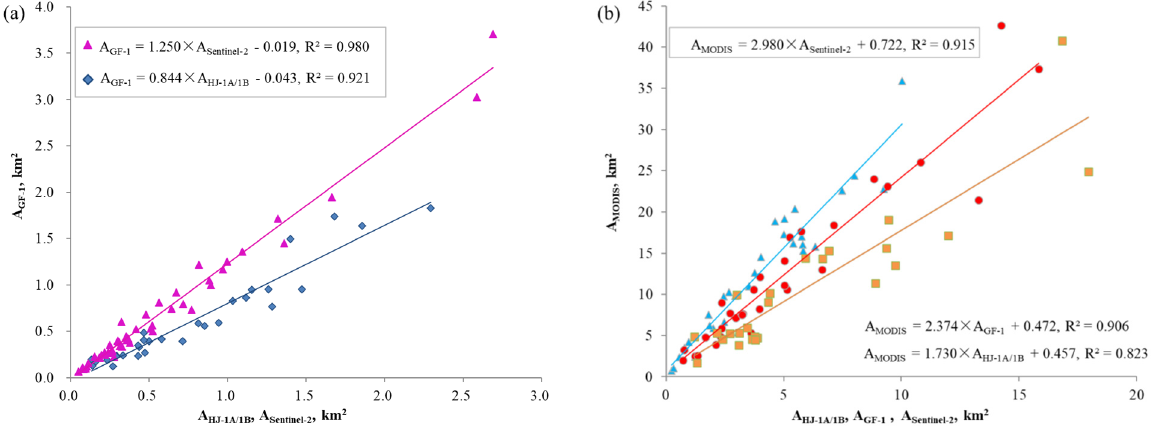
Figure 2. ( a ) Comparison in the macroalgae coverage areas derived from the optical images of HJ-1A/1B, GF-1 and Sentinel-2, i.e., A HJ-1A/1B , A GF-1 , A Sentinel-2 , respectively. ( b ) Comparison in the macroalgae coverage areas derived from the optical images of MODIS, HJ-1A/1B, GF-1 and Sentinel-2, i.e., A MODIS , A HJ-1A/1B , A GF-1 , A Sentinel-2 , respectively.